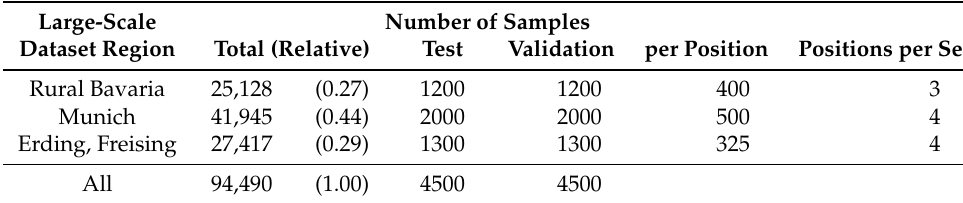
Table 4. Distribution of validation and test set samples across the regions in the large-scale dataset.